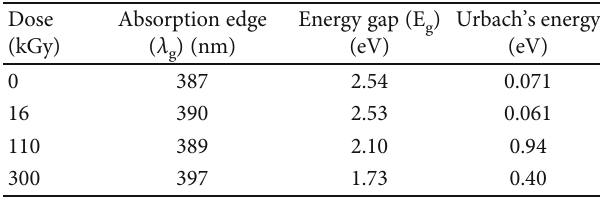
Table 1: Absorption edge and energy gap variation in virgin and irradiated samples of UHMWPE at di ff erent doses.